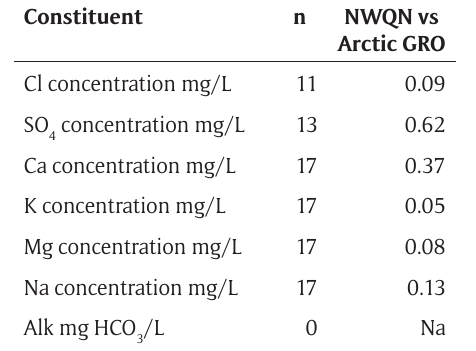
Table 4: Results of the paired t-test analysis comparing NWQN and Arctic GRO results. Values represent the probability that concentrations or loads were the same. Probabilities have been adjusted for the number of comparisons made. * significant (p < 0.05) ** highly significant (p < 0.01). [n, number of samples; Cl, Chlo- ride; SO , Sulfate; Ca, Calcium; K, Potassium; Mg, Mag- 4 nesium; Na, Sodium; Alk, Alkalinty; mg/L miligrams per liter; HCO /L milligrams of bicarbonate per liter; 3 NWQN, National Water Quality Network; Arctic GRO, Arctic Great Rivers Observatory; na = not available].